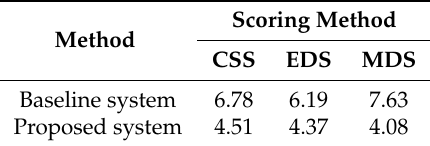
Table 3. The speaker verification system performance in terms of % equal error rate (EER).